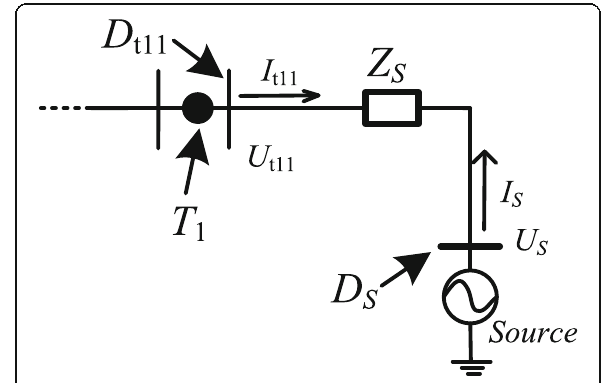
Fig. 4 Signal source and its information